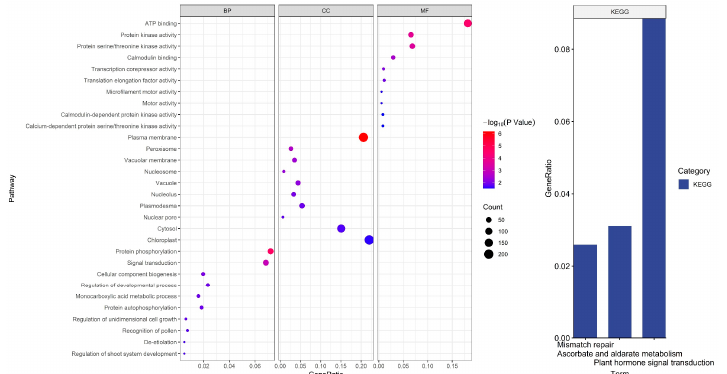
Figure 2. Target genes function enrichment analysis and KEGG pathway results.